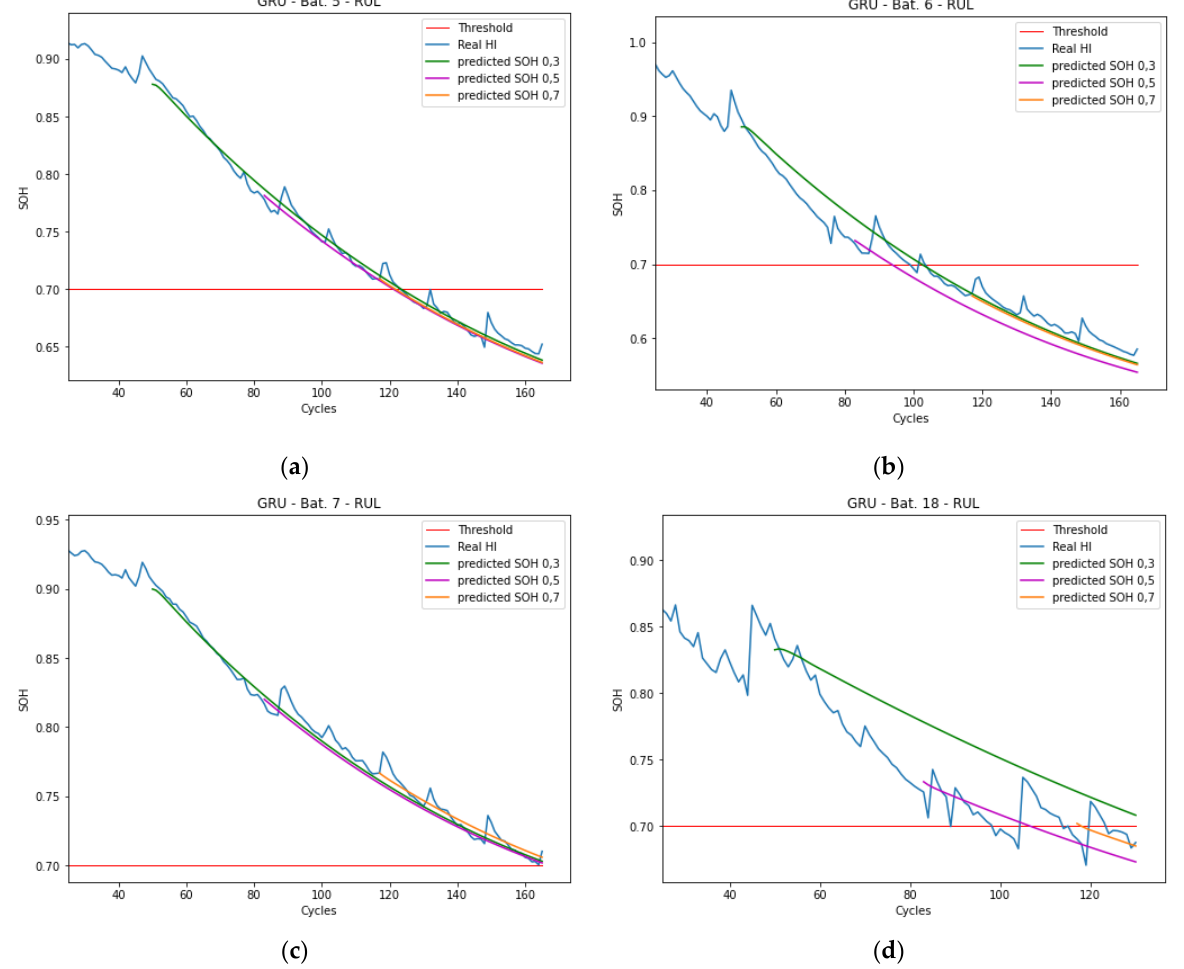
Figure 8. The RUL prediction results at different starting points for batteries ( a ) Bat. 5; ( b ) Bat. 6; ( c ) Bat. 7; ( d ) Bat. 18. Table 5. The RUL prediction results with different starting